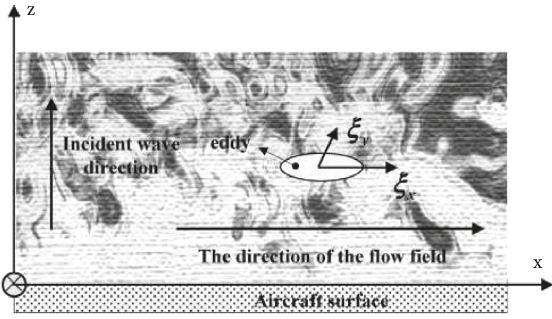
Figure 1: Sketch of hypersonic turbulence (figure from